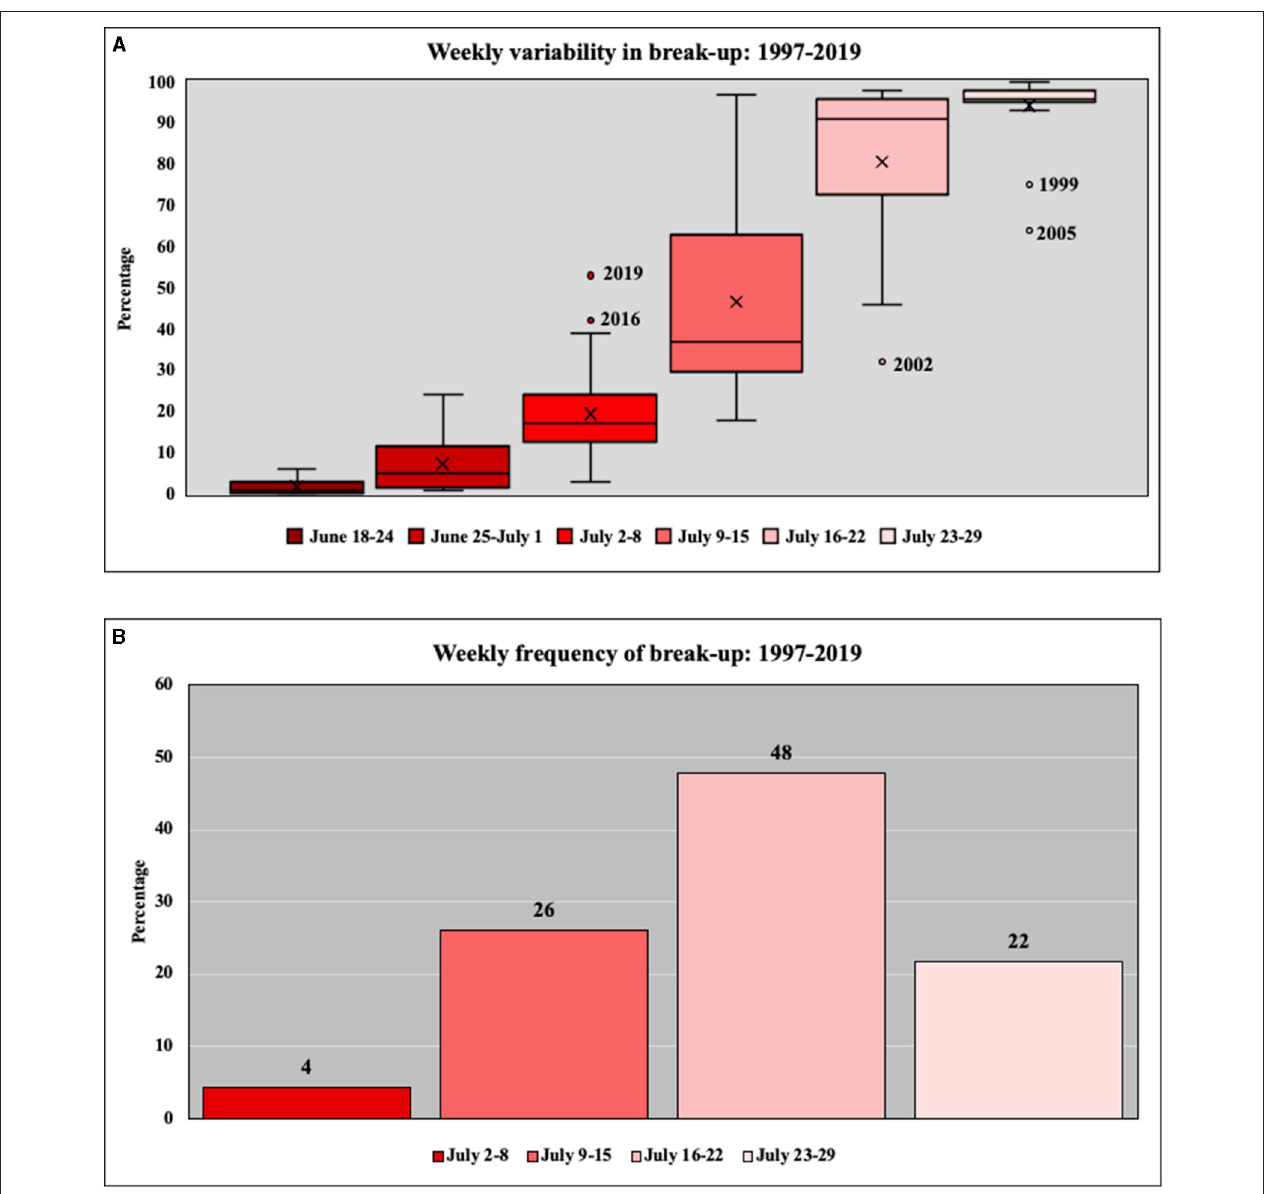
FIGURE 13 | (A) A summary of the weekly variability in break-up from 1997 to 2019. The box outlines the interquartile range, the average range in the variability of break-up for each week over the 23-year period (1997–2019). The line through the box is the median and the X denotes the mean. The vertical “whisker” lines show the minimum and maximum values. The dots correspond to outliers, or years with unusual break-up percentages. (B) Weekly frequency of break-up,